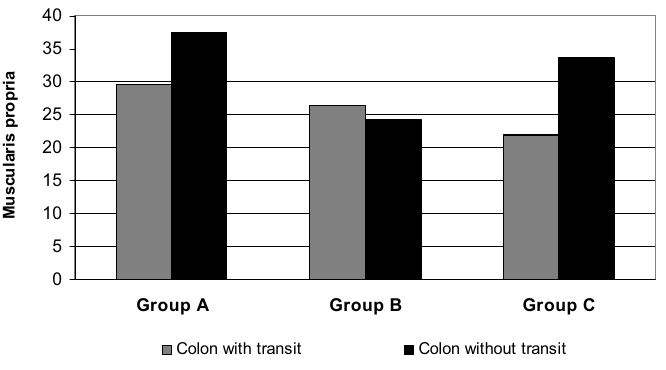
FIGURE 4 - Measurements obtained from computerized morphometry on the thickness of the colon muscularis propria, in the segments with and without intestinal transit in the experimental groups. Data is present as mean of micrometers. Student t test: p< 0.01 for group A; p< 0.0001 for group